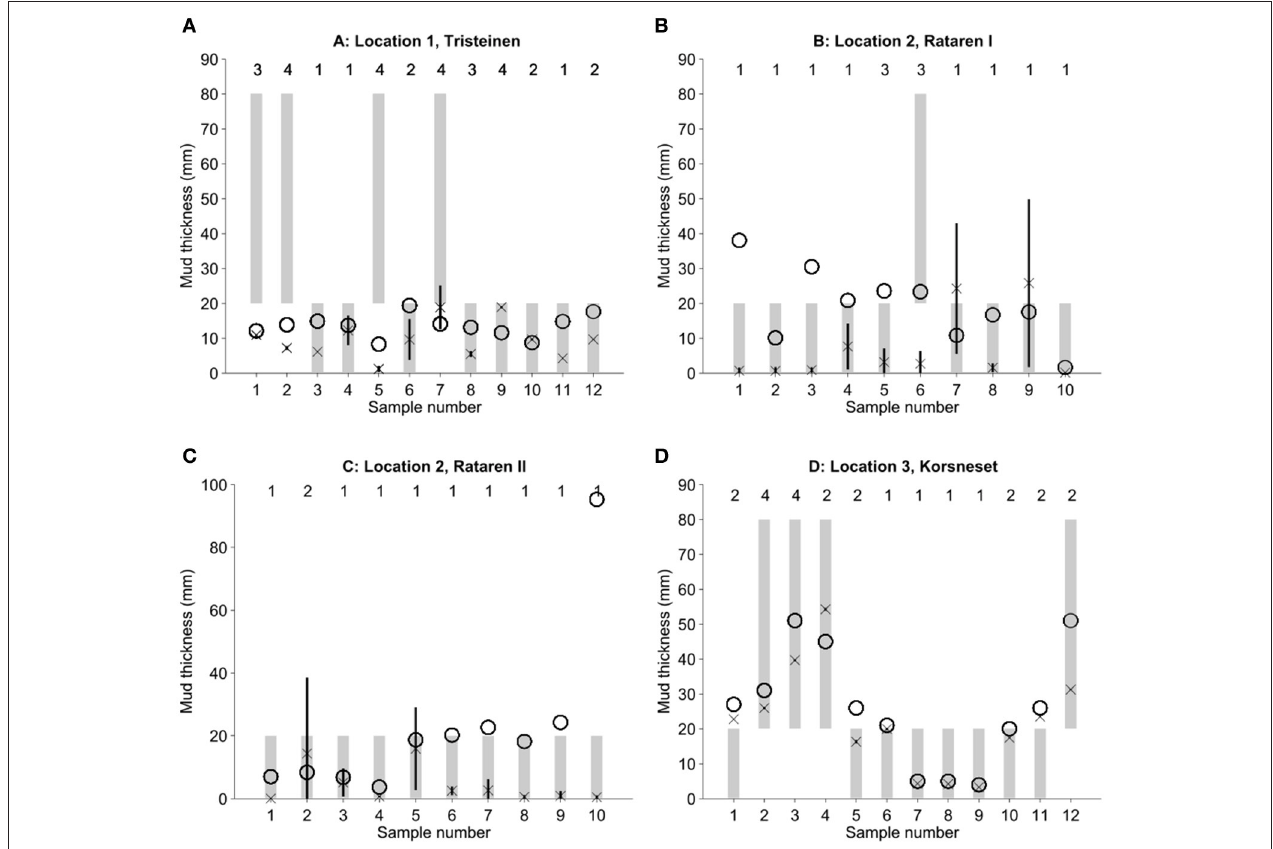
FIGURE 10 | Comparison of simulated and observed mud thickness at each of the four farms. (A) Location 1 (Tristeinen). (B) Location 2 (Rataren), western array I. (C) Location 2, eastern array II. (D) Location 3 (Korsneset). The locations for sediment sampling for each of the four farms are shown in Figure 8 . The sample numbers in Figure 8 and the present figure correspond (below abscissa). The gray bars indicate the recorded interval of mud thickness from the MOM surveys ( Table 1 ). Time-averages (n = 3, time step 12 h for location 1, 6 h for location 2, and 24 h for location 3) of simulated values, with resuspension, at the corresponding points are represented by × s, while the thin black lines represent standard deviations. The final MOM scores (including chemical assessments) of the samples are plotted above the axes. The circles represent mud thicknesses simulated without